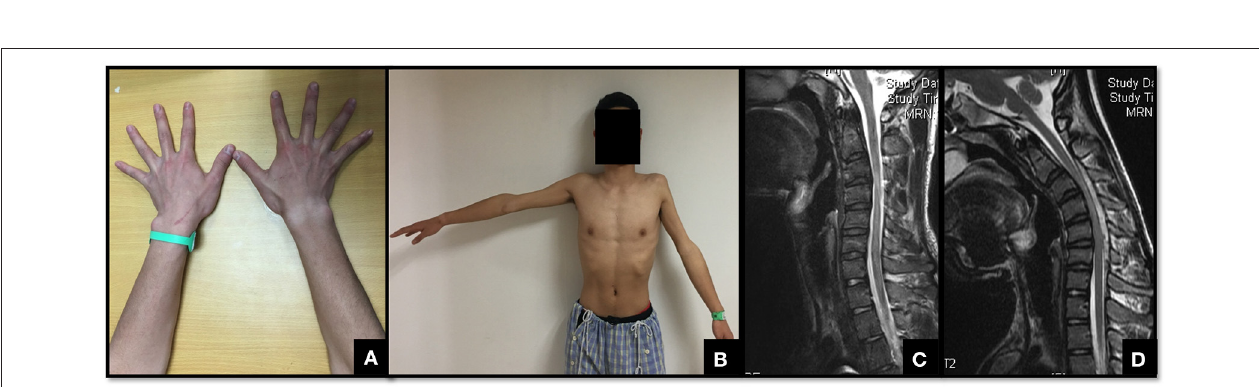
FIGURE 3 | An 18-year-old male with atrophy of the bilateral upper limbs for ∼ 1 year. There was a continued progression of weakness in the most recent 6 months. (A,B) show the apparent atrophy of the first dorsal interosseous muscle in the right and the deltoid in the left. The patient could not keep the left arm raised laterally for more than 10s. (C) shows that the spinal cord was significantly thin from C3 to C6. (D) shows the cyst–wall separation behind the spinal cord in the cervical flexion position. This patient was bilaterally affected, especially in the proximal part of the left arm. His deep tendon reflexes were active and the Hoffmann’s signs were positive on both sides, without sensory dysfunction. As a result, he was classified as having Type III Hirayama disease.